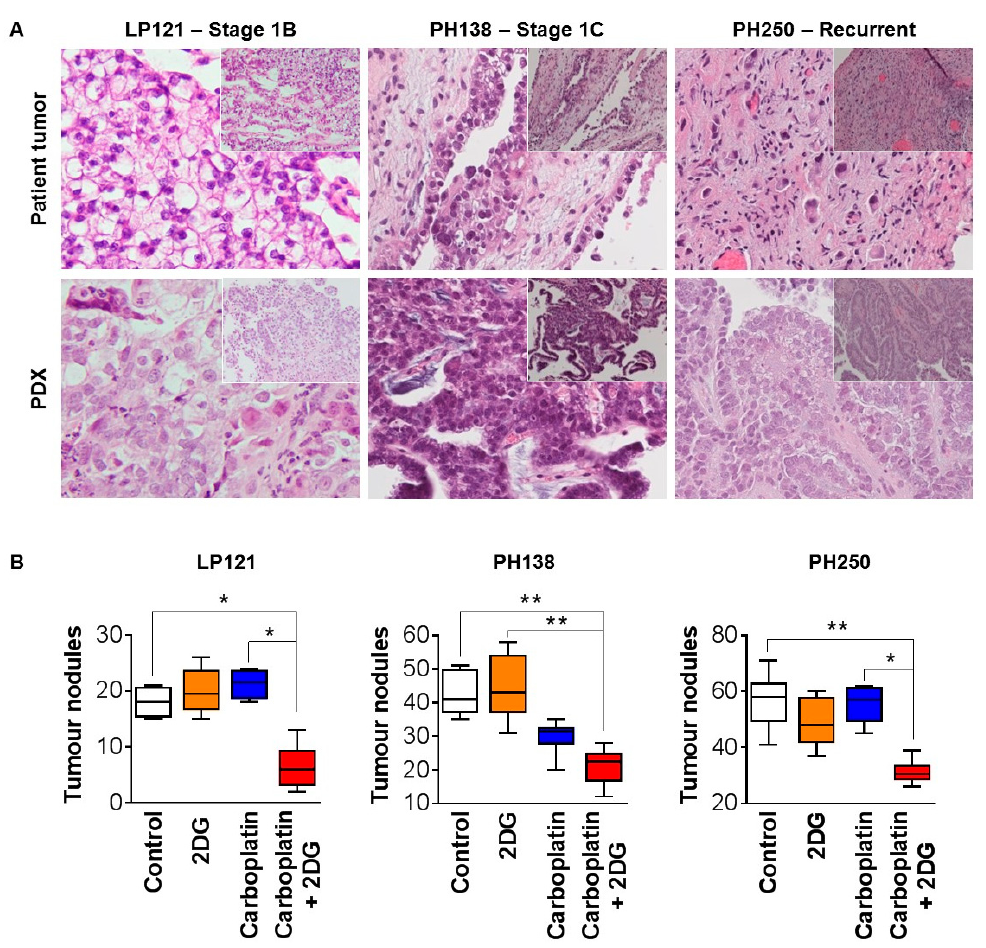
Figure 5. Combined with carboplatin, 2DG reduces tumor burden of PDX models of OCC. ( A ) Images of hematoxylin and eosin stained sections of representative tumors from patient LP121, PH138 and PH250, and PDX models developed from these tumors. Morphological features of patient tumors are retained in the corresponding PDX. ( B ) Graph of tumor nodules ≥ 8 mm 3 . For each model cell, slurry was injected i.p. into female NSG mice. After two weeks of growth, tumors were treated with PBS (control), 2DG (50 mg / kg twice weekly), carboplatin (1 mg / kg / week), or 2DG and carboplatin. Treatments continued until control mice reached ethical endpoint, when all mice were euthanized, and tumor burden quantified by counting tumor nodules ≥ 8 mm 3 . Results are presented as mean +/ − SD. *, p ≤ 0.05; **, p ≤ 0.01.